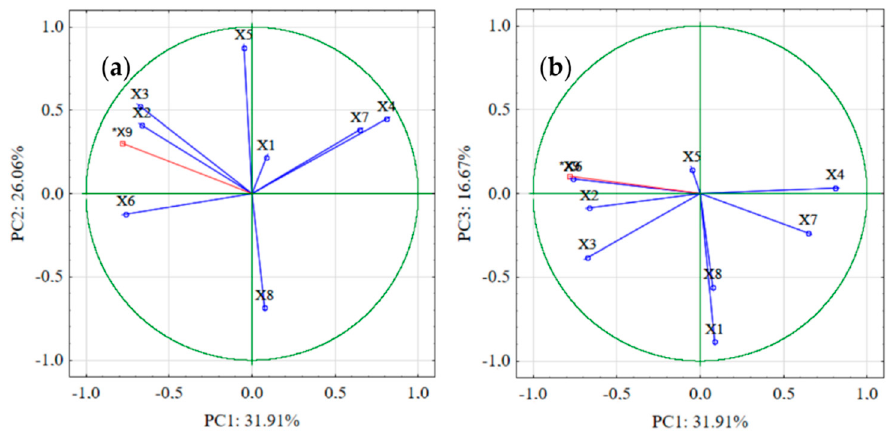
Figure 4. Biplot: ( a ) PC1 × PC2; ( b ) PC1 × PC3.